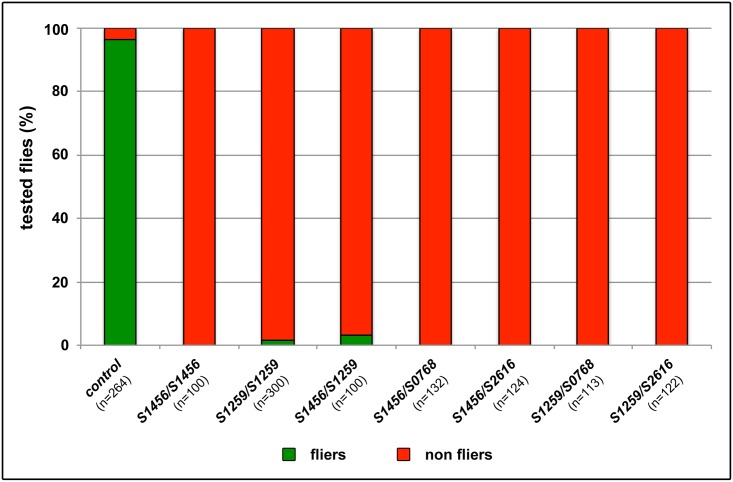
Hypomorphic mib2 mutants and various allelic combinations are flightless.As compared to EMS control flies, homozygous mib2S1456 and mib2S1259 mutant flies, and those corresponding to different allelic combinations are essentially flightless.